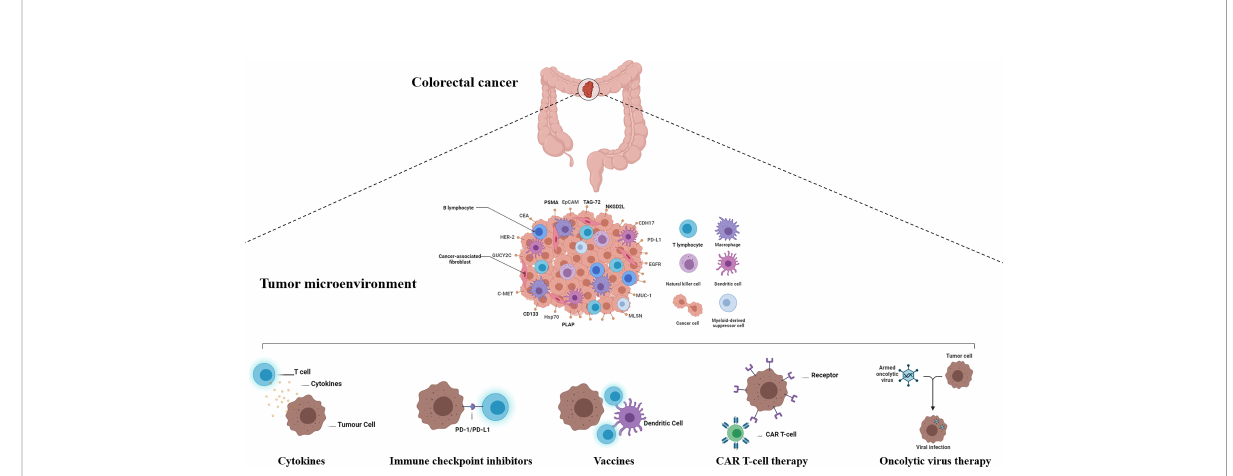
FIGURE 2 Active and passive immunotherapy strategies in colorectal cancer. The immunotherapy treatments approved in recent years has widened the arsenal against colorectal cancer. Active immunotherapy includes cancer vaccines, checkpoint inhibitors, and oncolytic viruses. Cancer vaccine immunotherapy approaches are based on immunizing patients with cancer against their autologous cancers using either autologous tumor cell- derived vaccines, dendritic cell vaccines, peptide vaccines, DNA vaccines, or viral vector vaccines. Passive immunotherapy includes the use of immune checkpoint blockade, cytokines, and adoptive cell transfer of ex vivo educated immune cells (Source: Author ’ s personal collection, 2021). Created with